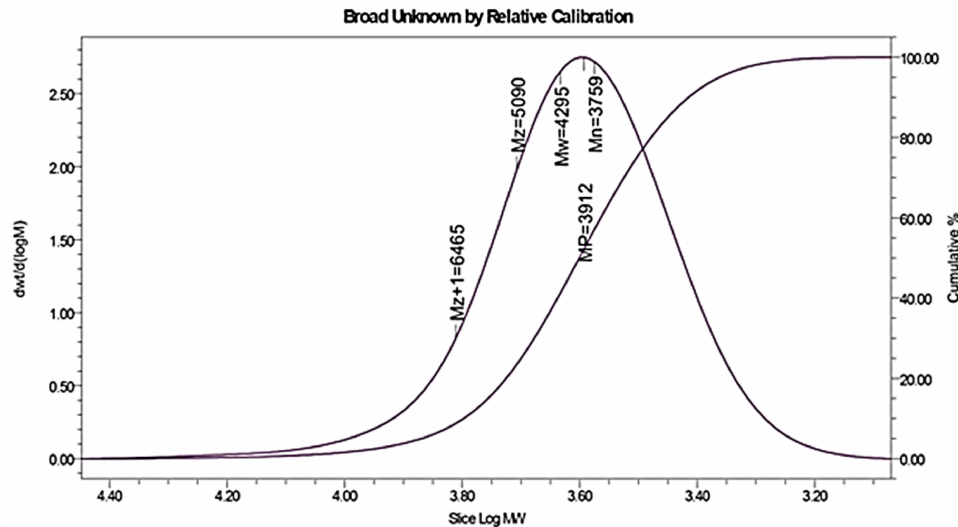
Figure 9. GPC chromatogram of the P(MLA20- g -LLA) 1:30 showing the average molecular weight values of: M Z + 1 , M Z , M w , and M n ,